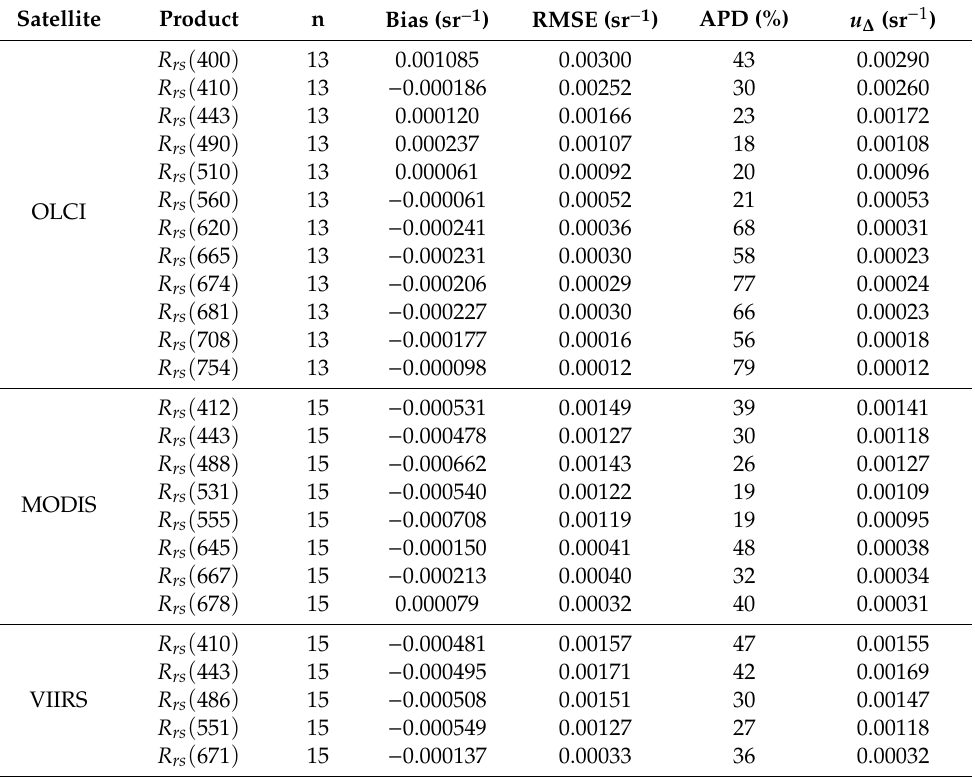
Table 3. Statistical parameters of OLCI, MODIS, and VIIRS around the China